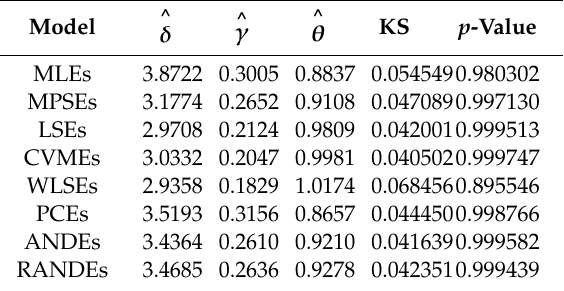
Table 4. The estimates of the OEHLE parameters using eight estimation methods, KS and p -value for the gauge lengths data.